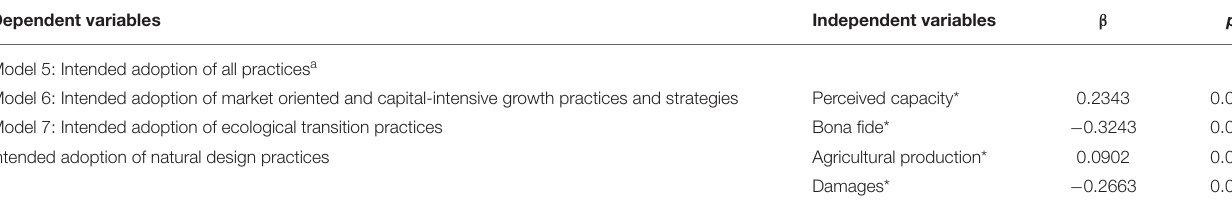
TABLE 7 | Significant results of generalized linear regression models for farmers intended